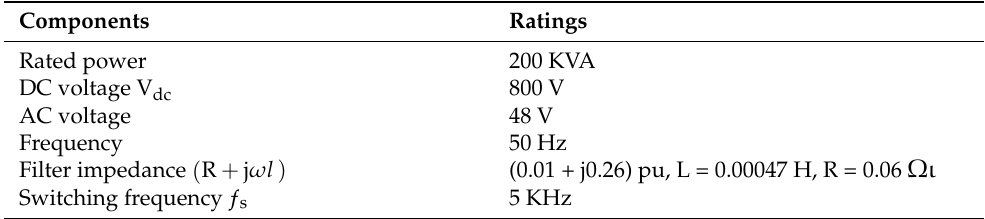
Table 2. The parameter values for circuit configuration in the proposed approach *.